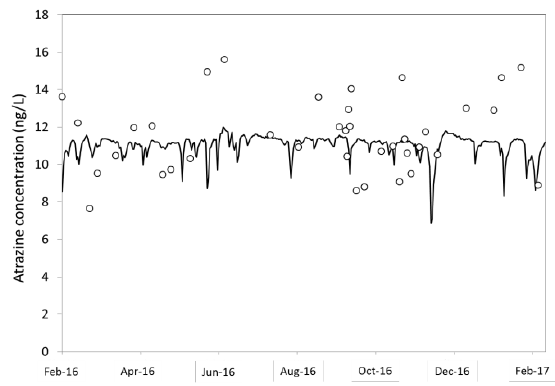
Figure 7. Atrazine concentration in the surface water at Canche 5 . Markers indicate the experimentally- measured concentrations and the line refers to the calculated concentration assuming that atrazine in the surface water was exclusively supplied by the ground water seepage (Equation (3)).